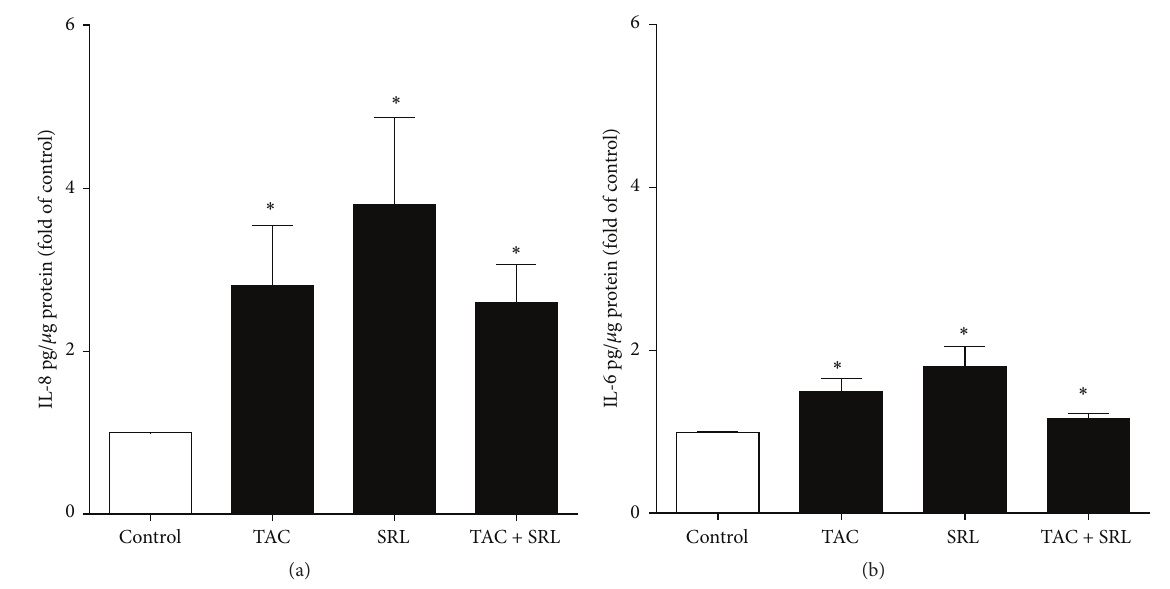
Figure 3: The effect of immunosuppressant drugs on protein release of IL-8 and IL-6 in human islets. Human islets cultured without or with tacrolimus (TAC 30 𝜇 g/L), sirolimus (SRL 30 𝜇 g/L), or a combination thereof for 24 hours. Protein levels of (a) IL-8 and (b) IL-6 in human islets were investigated in cell lysate using multiplex bead-based cytokine assay (Bio-Plex Human Cytokine Group 1). Data is presented as mean ± SEM of four separate experiments from four different donors. ∗ 𝑝 < 0.05 versus